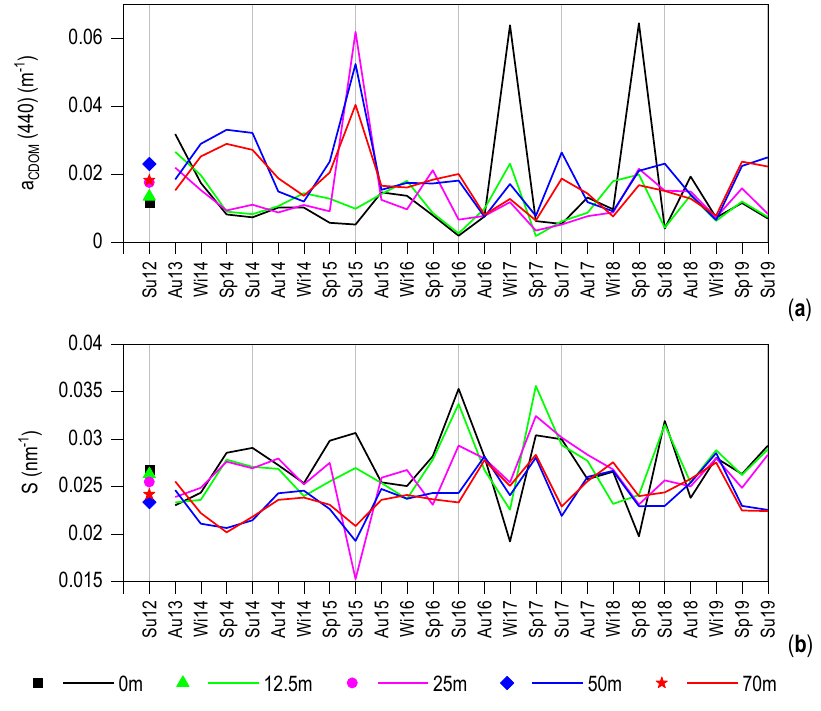
Figure 4. Temporal evolution of: ( a ) a CDOM (440); ( b ) S .